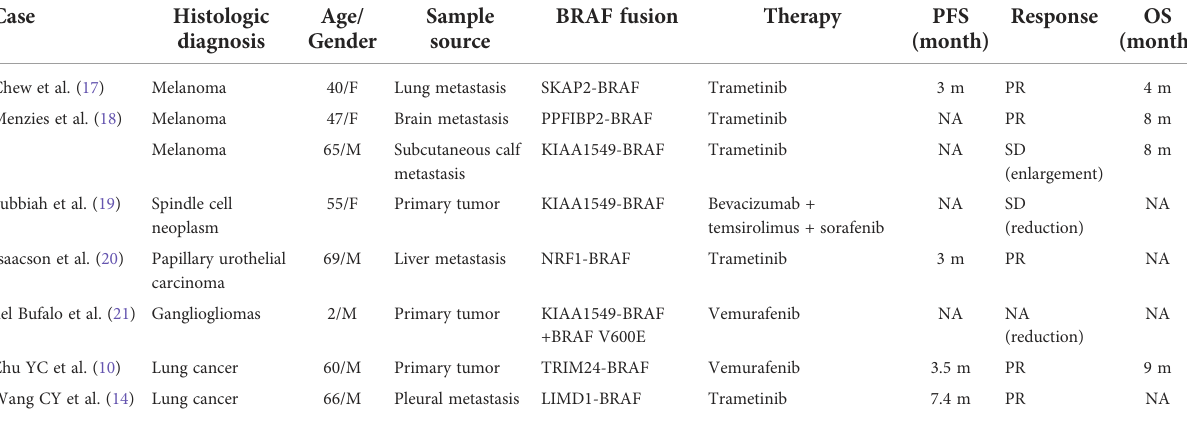
TABLE 1 Literature review on anti- BRAF therapies used in solid tumors with BRAF gene